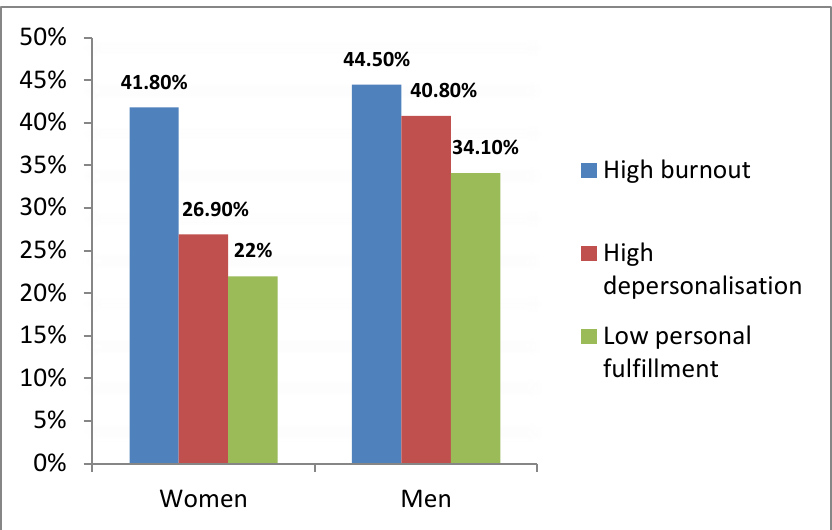
Figure 2. Percentages of high depersonalization, high emotional exhaustion, and low personal realization in men and women.